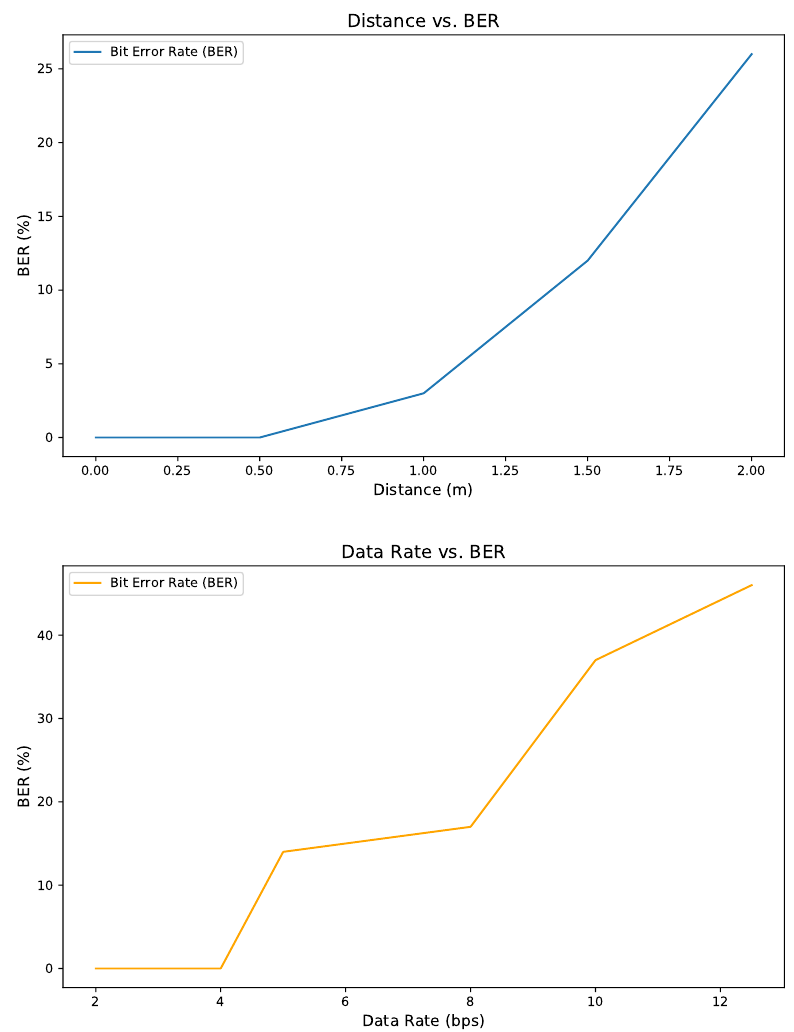
Figure 5. Bit error rate with respect to the distance and data